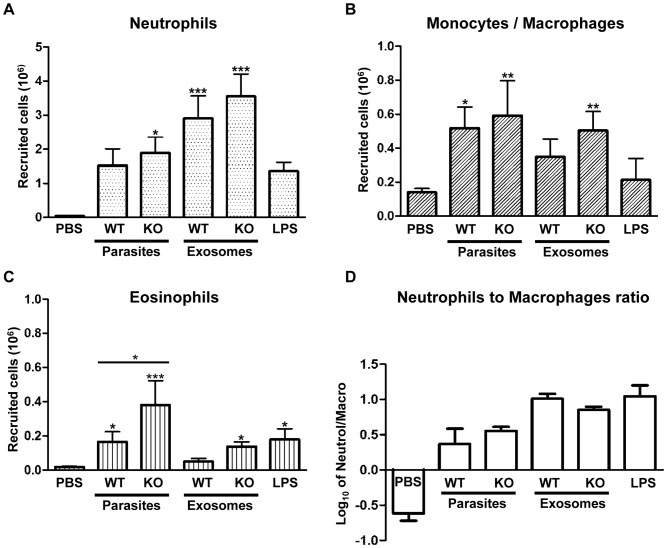
Recruitment of inflammatory cells to the air pouch in response to Leishmania parasites and exosomes.A, B and C show recruitment of neutrophils, monocytes/macrophages and eosinophils/mast cells calculated based on differential count respectively. D shows Log10 of the neutrophil/macrophage ratio, illustrating stronger recruitment of macrophages by parasites, compared to exosomes. Results show average of 3 separate experiments plus SEM. Statistical significance is measured against PBS-injected mice unless specified with a line (*: P-value <0.05, **: P-value <0.001, ***: P-value <0.0001).